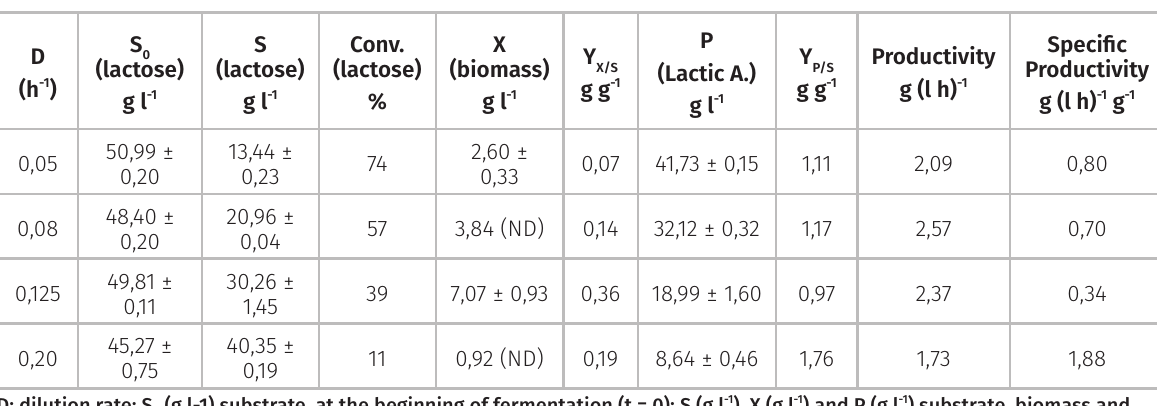
Table I. Kinetics of Lacticaseibacillus paracasei continuous